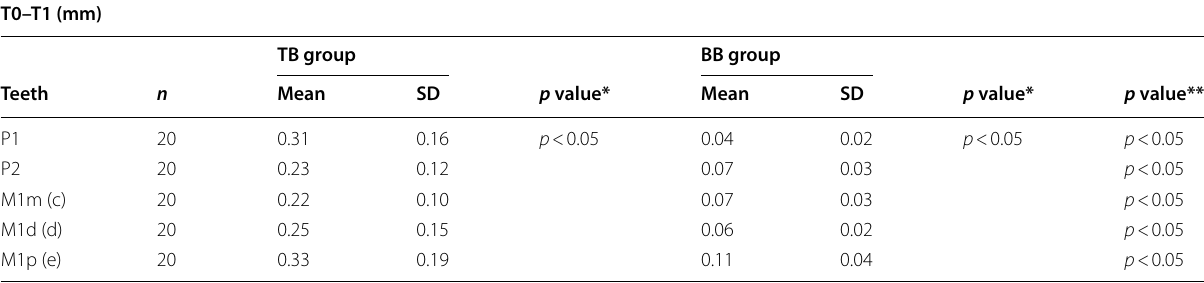
Table 2 Descriptive and inferential statistics of radicular length changes occurred after maxillary expansion